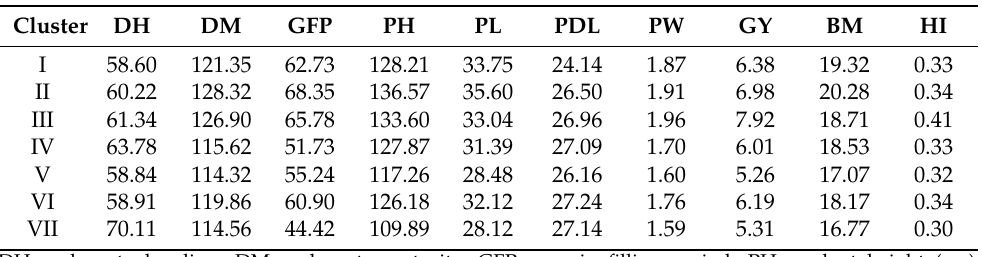
Table 7. Cluster means of grain yield and yield-related traits of teff genotypes under the intensive growing condition.